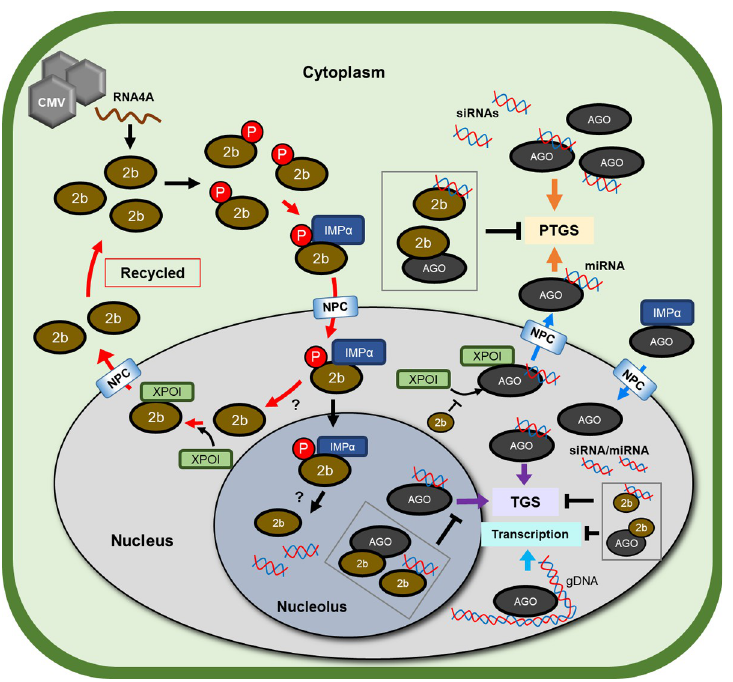
Fig 8. Summary of possible interactions between 2b and players in the RNA silencing pathway in cells. Subcellular trafficking of 2b and its operation points to suppress RNA silencing are shown as red bold arrows. Cytoplasmic 2b is first phosphorylated by a host kinase. The phosphorylated 2b can interact with IMP α , and the 2b/IMP α complex passes through the nuclear pore complex (NPC) into the nucleus and possibly into the nucleolus. AGOs are also imported into the nucleus and nucleolus in a similar IMP-mediated manner. 2b may be recycled after dephosphorylation by host phosphatase(s) in the nucleus or nucleolus; dephosphorylated 2bs will be exported to the cytoplasm in a XPOI-dependent manner, while they can interact with AGOs and sRNAs either in nucleus or nucleolus [37]. AGOs are also exported to the cytoplasm in a XPOI-dependent manner, transporting mature miRNAs to the cytoplasm [39]. Therefore, 2bs seem to shuttle between the nucleus and the cytoplasm as they efficiently track targets such as AGOs and